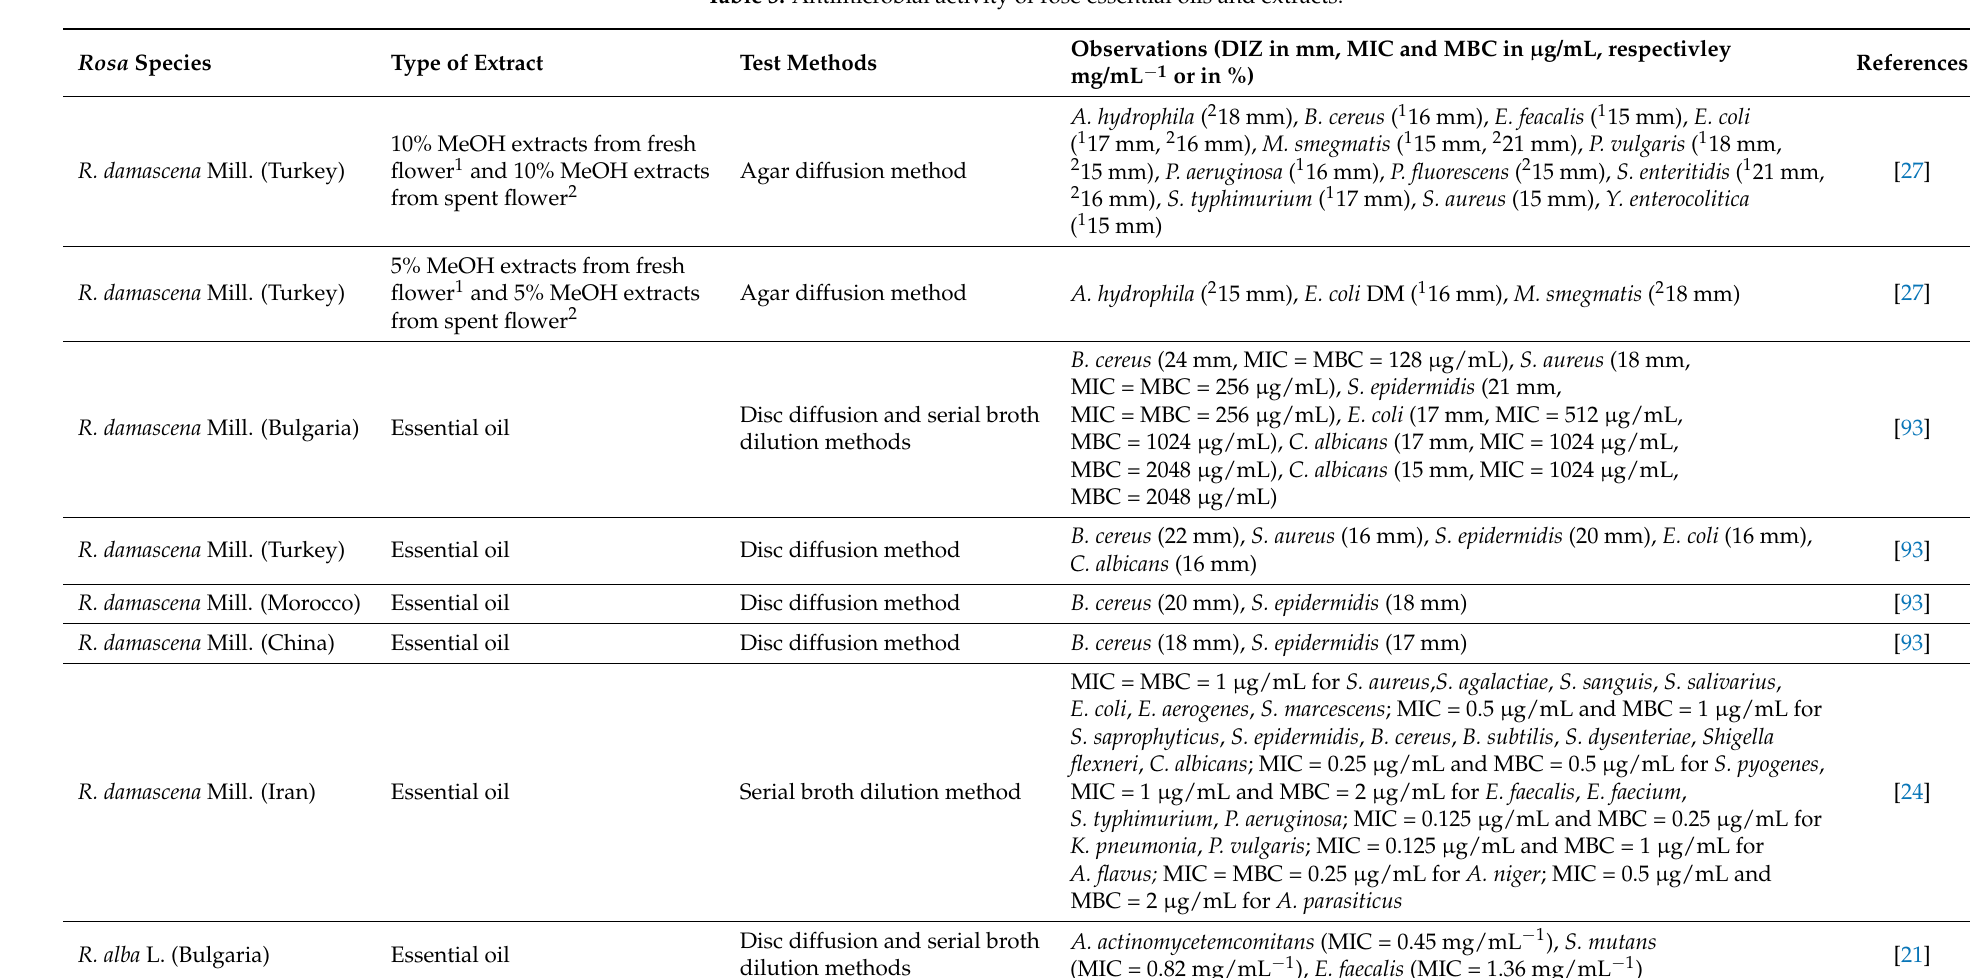
Table 3. Antimicrobial activity of rose essential oils and